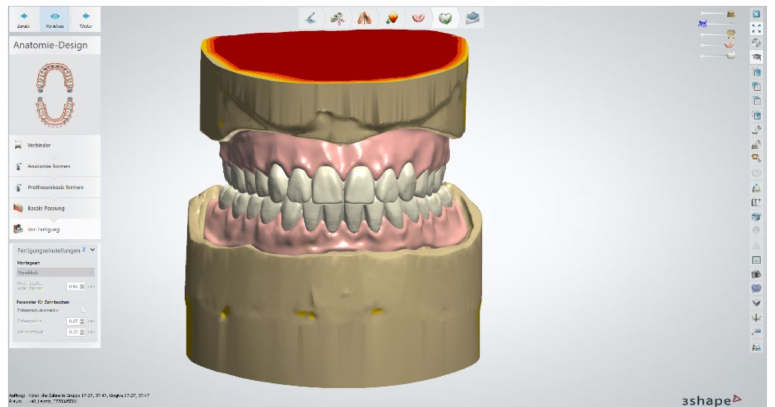
Figure 14. Construction of the definitive completed dentures in the upper and lower jaw.